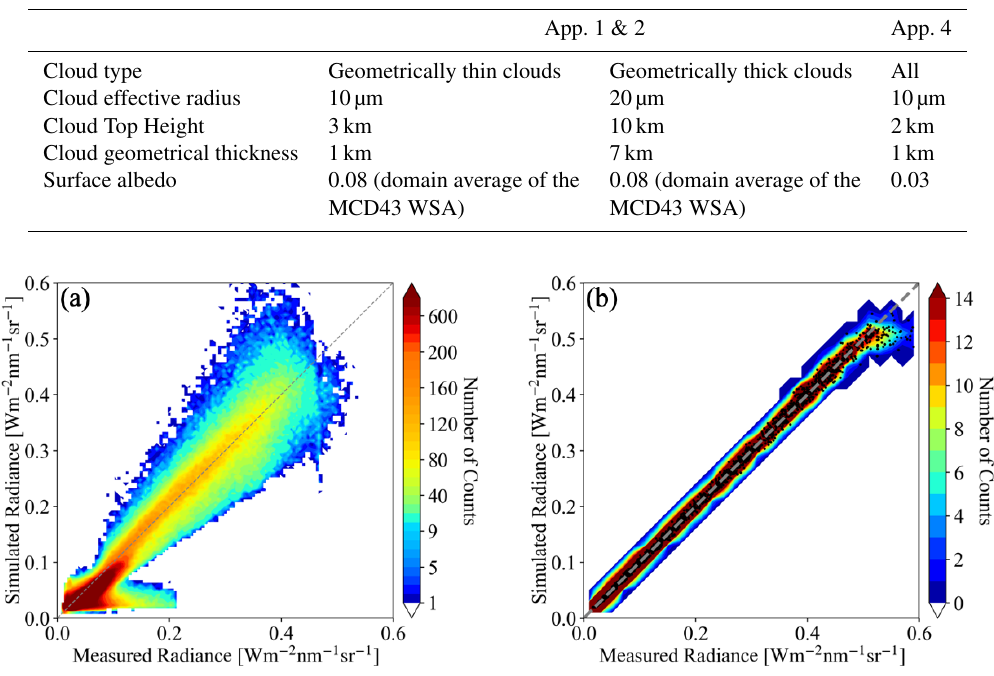
Figure C3. Panels (a) and (b) are the same as Figs. 7 and 13b except for the IPA radiance calculations.